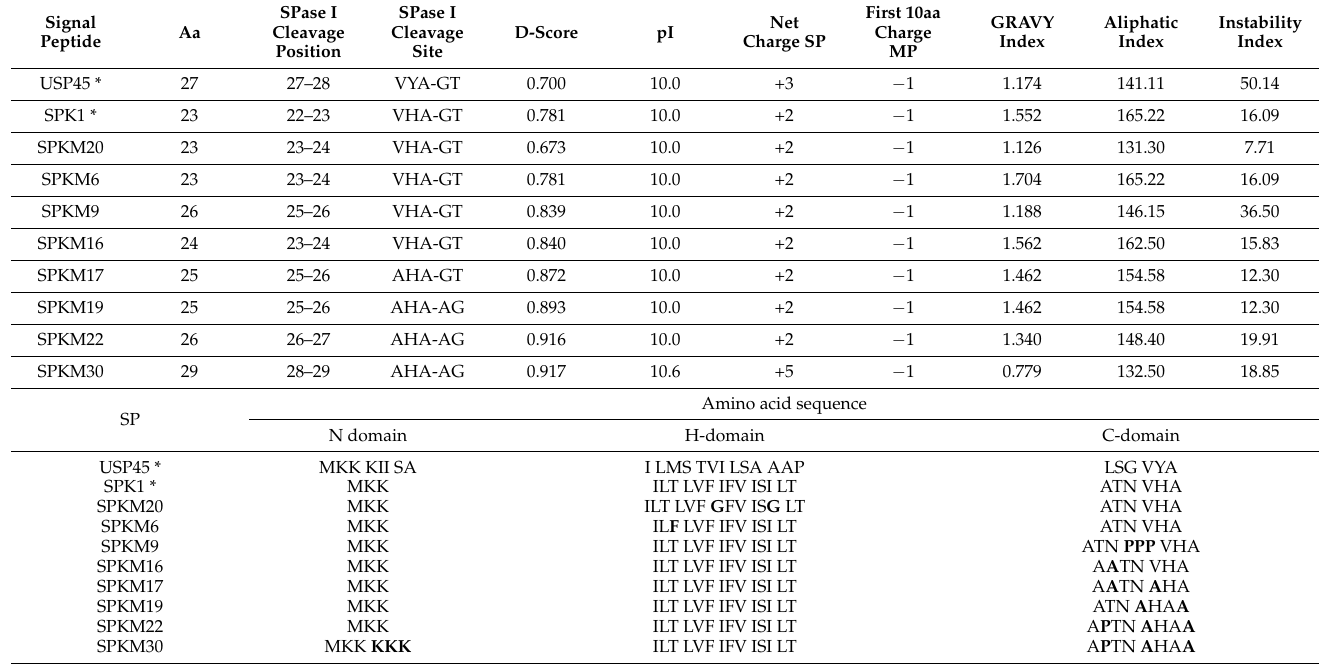
Table 1. Computational analysis of signal peptides used in this